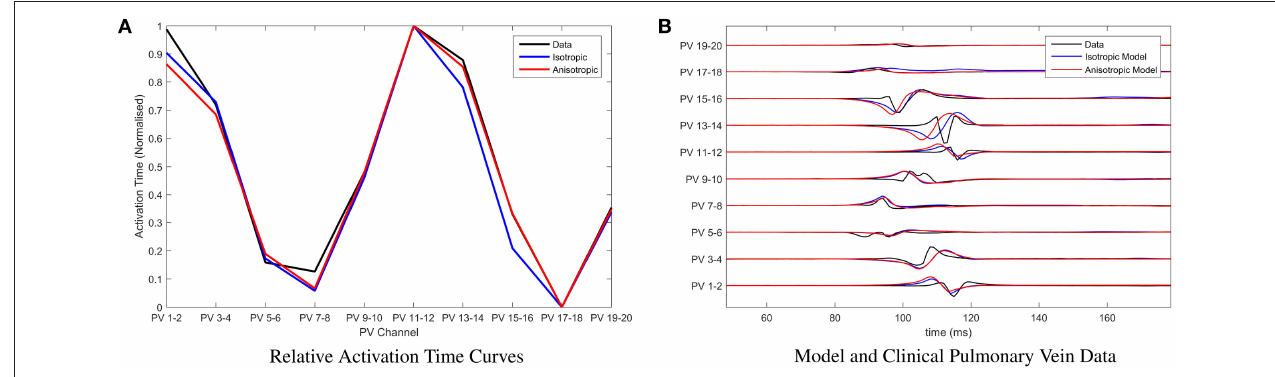
FIGURE 4 | Parameter fitting and comparison with clinical recordings. (A) Presenting the relative activation time curves for the clinical data (presented in full in B ) (black), the model assuming isotropic diffusion (blue) and the model assuming anisotropic diffusion (red). Parameters of the model were calibrated by minimizing the root mean squared error between clinical recording and the model using the Nelder-Mead method. (B) Presenting an exemplar of clinical pulmonary vein recordings collected during pulmonary vein isolation therapy at the Bristol Heart Institute (black). Overlaid are the model simulations, with parameters calibrated as described in (A) , under the assumption of isotropic diffusion (blue) and isotropic diffusion (red) respectively.